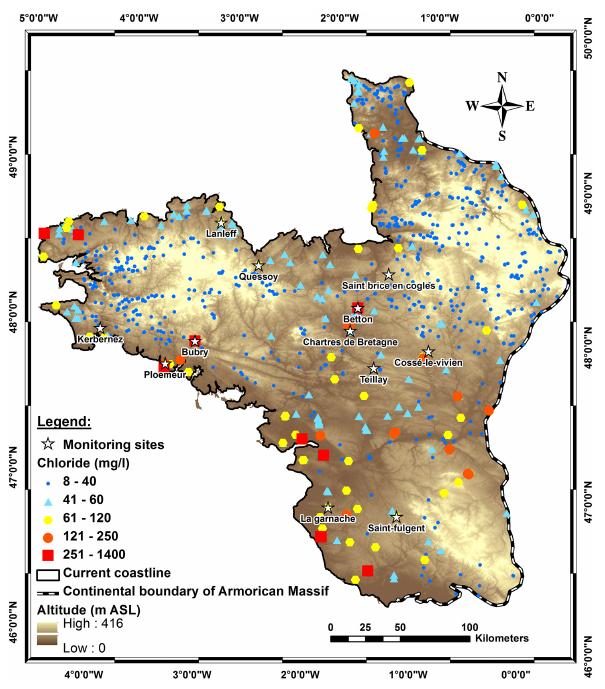
Figure 2. Map of the Armorican Massif including the distribution of chloride concentrations for the whole area (from a preprocessed chloride database) and the location of the 12 sites